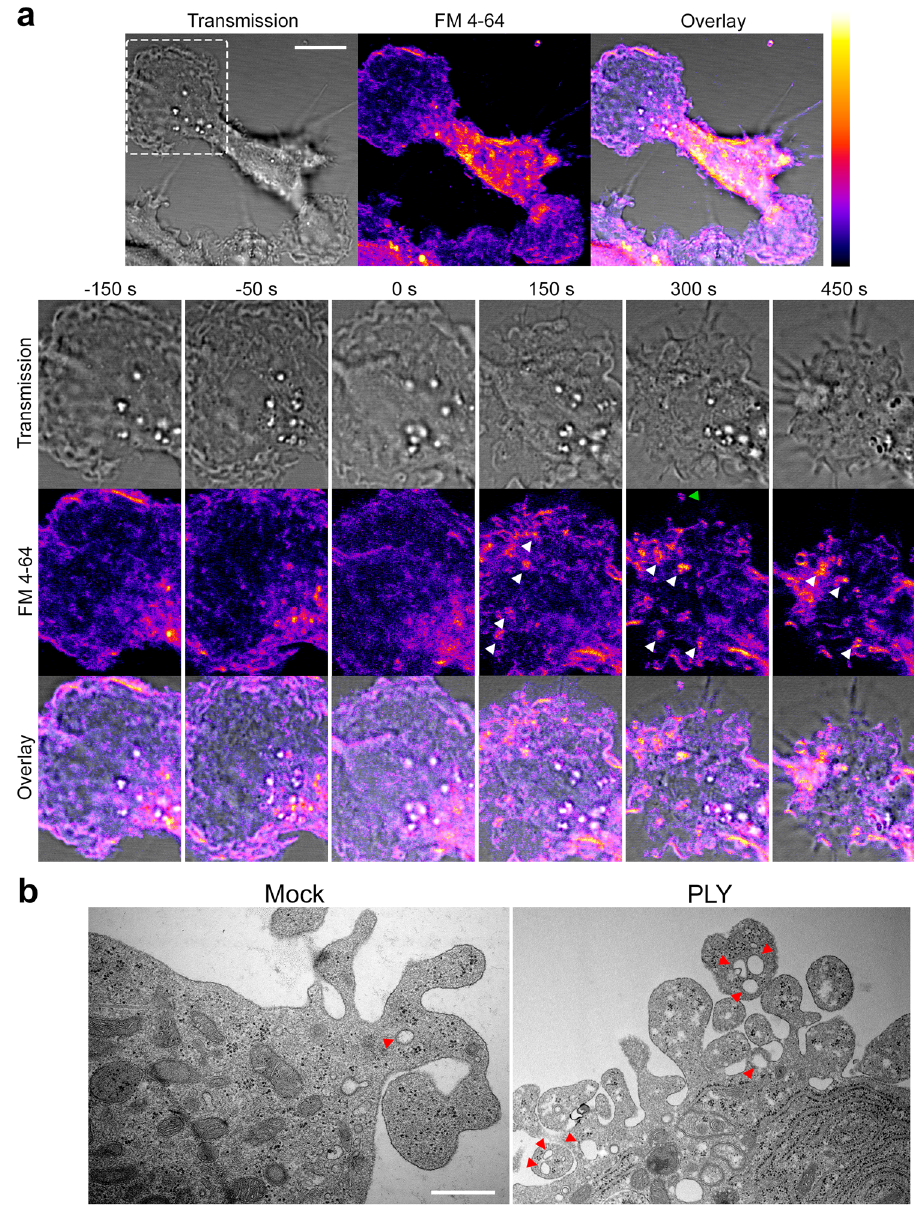
Fig. 5 | Time-lapse imaging of microglial membrane alterations after recom- binant PLY exposure. a High-resolution video microscopy of microglia in trans- mission and fl uorescent imaging (FM 4-64). The fragment in the fi rst image is magni fi ed in the following series (0s — time-point of treatment; see also Supple- mentary movie M2). Before treatment, the membrane demonstrates balanced randomwaves.Followingchallengewith2HU/mlPLY,thewavesredirectedtoward the body of the cell and slowed down, followed by retraction and clustering of the